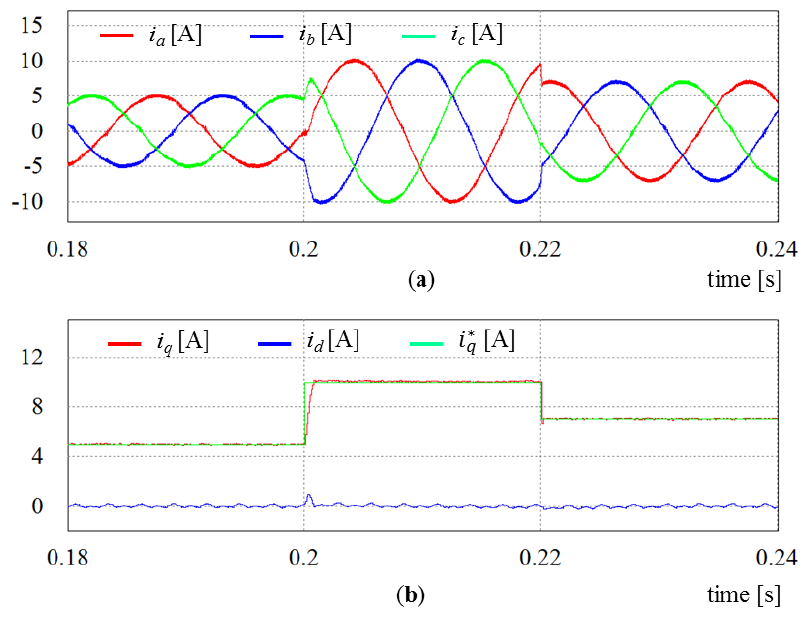
Figure 17. Transient responses of the proposed current control scheme under the distorted grid voltages with temporary replacement of the harmonic currents during transient period: ( a ) phase-currents; and ( b ) q- axis and d- axis currents.